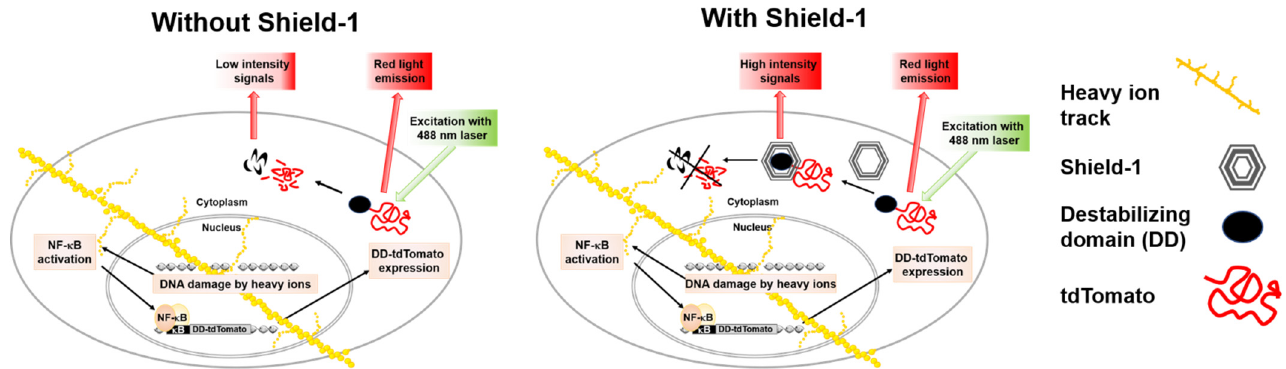
Figure 1. Principle of the HEK-pNF κ B-DD-tdTomato-C8 cells as reporter assay for NF- κ B activation. HEK cells were stably transfected with the plasmid pNF κ B-DD-tdTomato containing four κ B sites as binding sites for the transcription factor NF- κ B, which control the expression of the reporter protein DD-tdTomato. A heavy ion passing through the cell leads to a multitude of ionizations along its track (indicated as big yellow dots), and it produces secondary electrons that can give rise to ionizations outside of the primary particle track (small yellow dots). These ionizations can induce DNA double-strand breaks which initiate the activation of NF- κ B via the genotoxic stress-induced NF- κ B subpathway. Activated NF- κ B enters the cell nucleus and binds to κ B sites in promoters, including the κ B sites that control DD-tdTomato expression. The DD-tdTomato mRNA travels to the cytoplasm and is translated to the DD-tdTomato protein, whose red fluorescence can be detected after correct protein folding. DD-tdTomato is rapidly degraded in the absence of Shield-1 due to the destabilizing domain (DD). In the presence of Shield-1, DD-tdTomato is stabilized and accumulates in the cytoplasm, leading to a higher red fluorescence signal after excitation with the 488 nm argon laser of the flow cytometer.